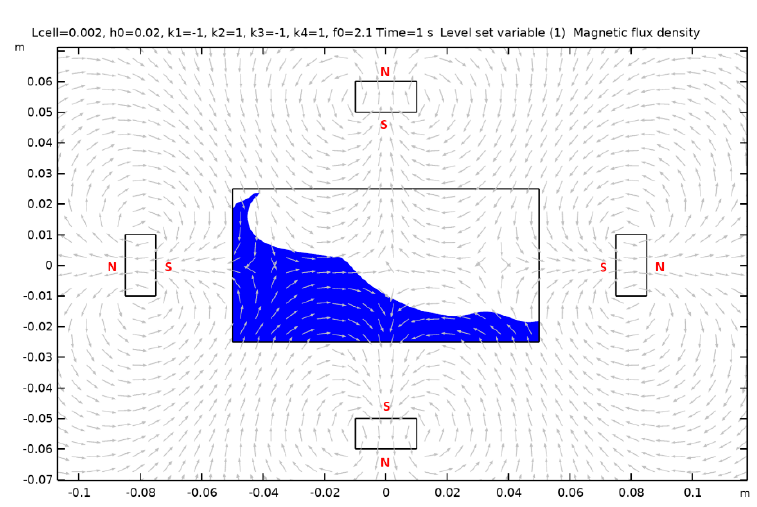
Figure A4. Case 5.